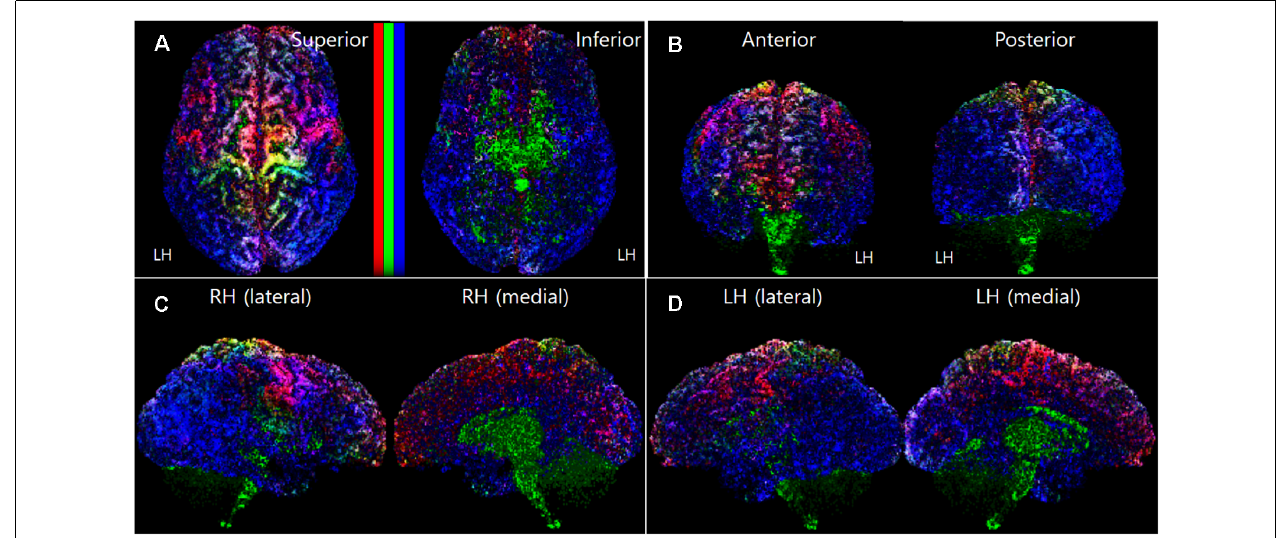
FIGURE 1 | A representative voxel-based TDRM (dataset ID: 105923) in the cerebral cortex with the three different primary colors (tracks for commissural fiber = red, projection fiber = green, association fiber = blue). (A) Superior and inferior view. (B) Anterior and posterior view. (C) Right hemisphere in lateral and medial view. (D) Left hemisphere in lateral and medial view. LH, left hemisphere; RH, right hemisphere; TDRM, track-density ratio map.